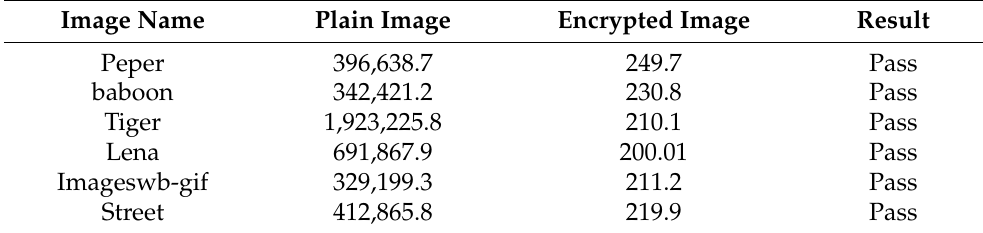
Table 2. The chi-square test of